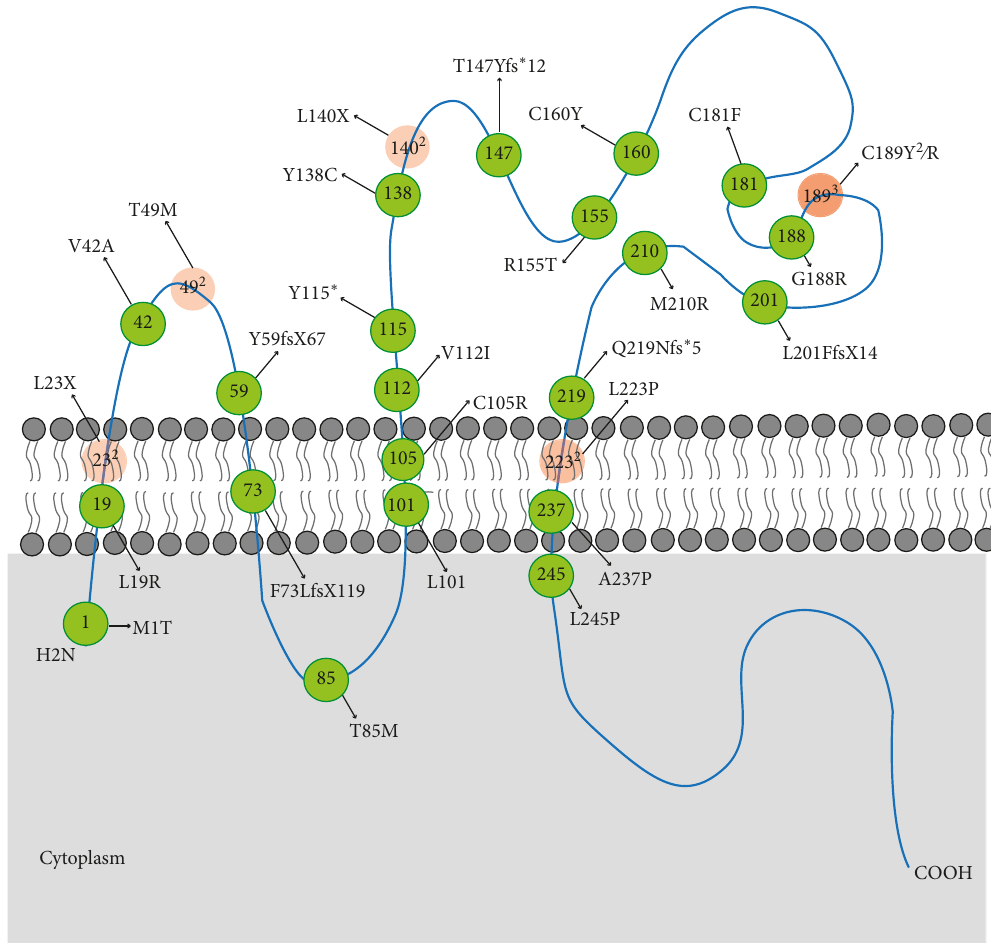
Figure 5: Schematic diagram of the TSPAN12 protein shows the location of the 31 known mutations within the protein domains. Nine splice-site mutations besides one mutation (c.916-918+ 3delTAAAAA) resulting in protein extension and one mutation (c.67-1G > C) resulting in frame shift are not shown in this diagram. Superscript number means the reported times of the same or different mutations at a certain site. The color of the mutations which were reported more than one time was recolored as orange. The opacity varied with the reported frequency of the